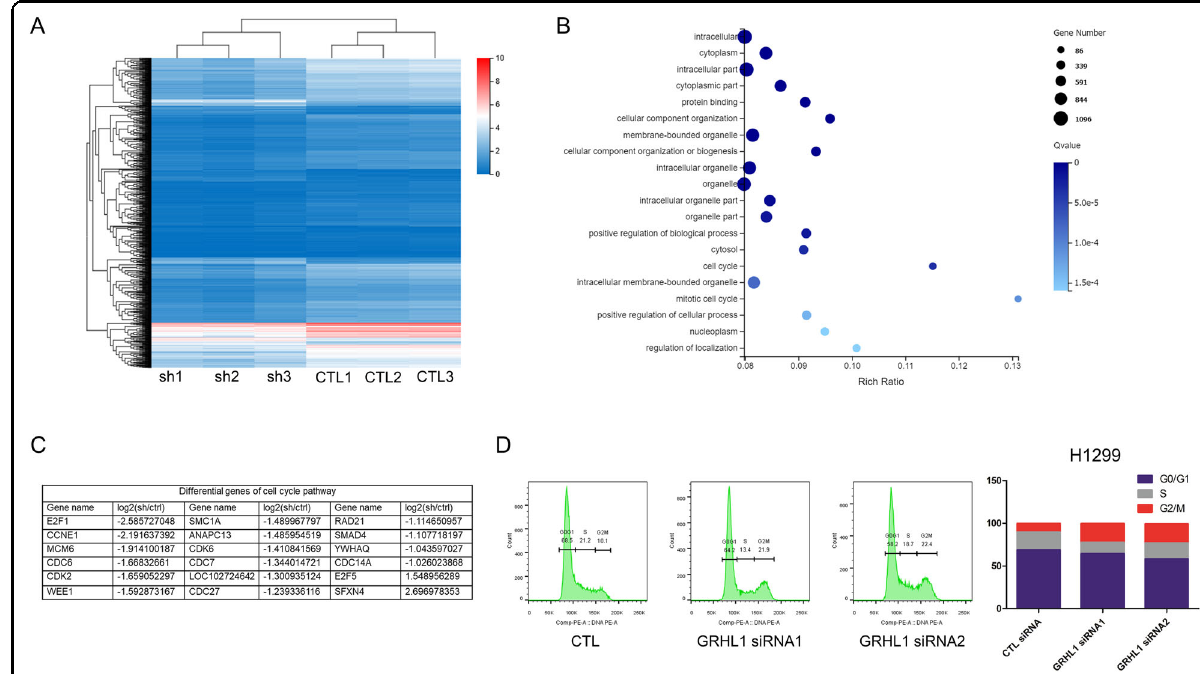
Fig. 3 GRHL1 knockdown in fl uences cell cycle progression and arrests the cell cycle in the G2/M phase. A – C RNA-sequencing. The samples using wild-type A549 (CTL) and A549-shGRHL1 (sh) cell lines, CTL and shGRHL1 groups contain 3 repeat groups respectively. The samples were sequenced in BGI (Beijing Genomics institution). A Cluster heat map of 1379 differentially expressed genes regulated by GRHL1. The horizontal axis represents log2(FPKM + 1) of samples, and the vertical axis represents genes. The redder color indicated the higher expression level and the bluer color indicated the lower expression level. B GO enrichment bubble diagram: according to the results of GO annotation and of fi cial classi fi cation, classi fi ed the differential genes functionally and conducted enrichment analysis. C The differential genes of cell cycle pathway. D H1299 cells were transfected with either control (CTL) siRNA or GRHL1 siRNAs. After 24 h, cell cycle analysis was done by fl ow cytometry. The inserts show the quanti fi cation of the cell cycle